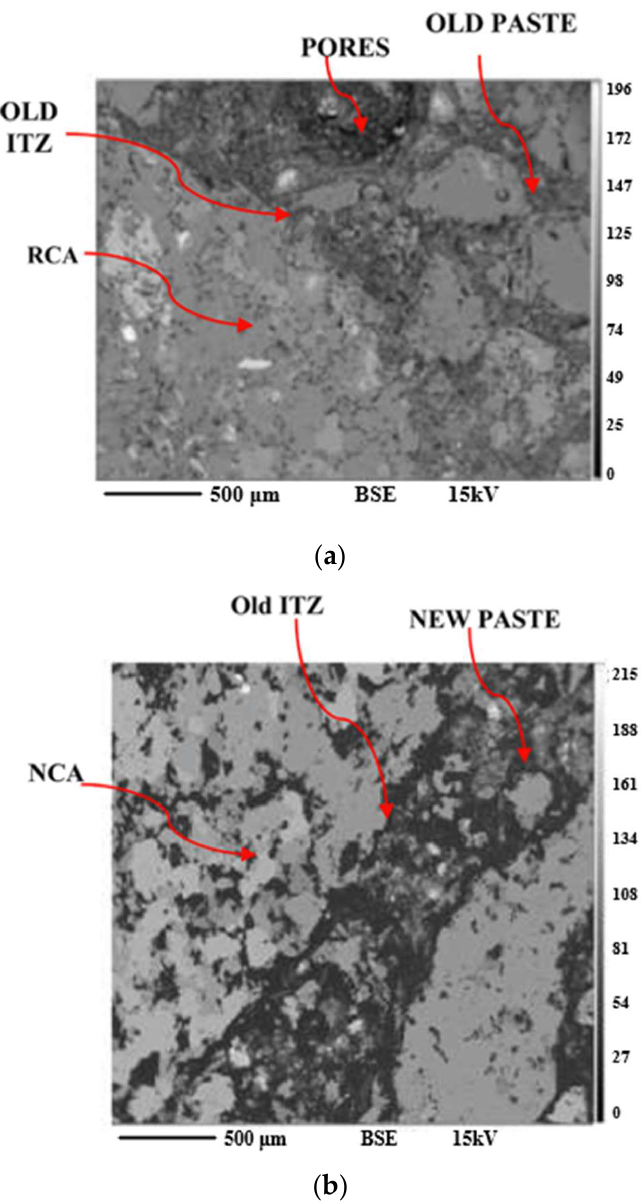
Figure 13. ( a ) Porous old ITZ and normal mixing; ( b ) dense old ITZ after TSMA [43]. Reproduced with permission from [43], Elsevier, 2020.